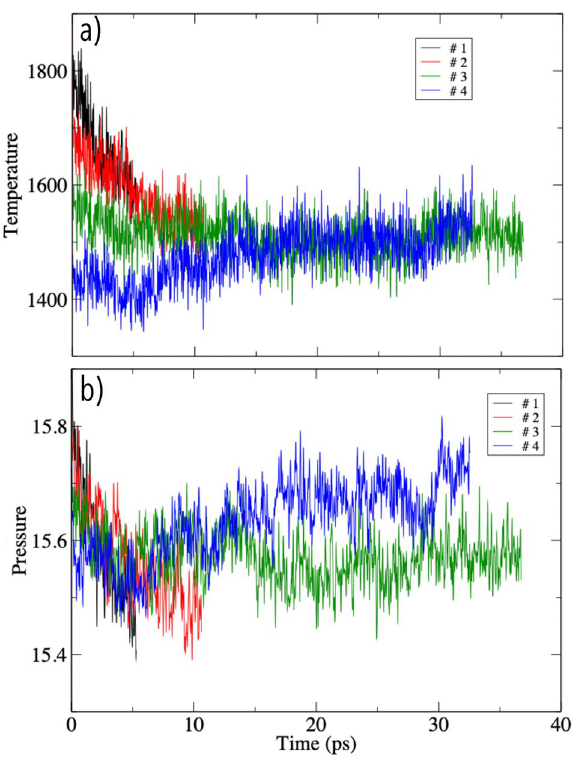
Figure 5. Instantaneous ( a ) temperature and ( b ) pressure of four solid-liquid coexistence simulations with different amount of internal energy. Simulation # 1 and # 2 both melt after ~ 5 and ~ 10 ps, respectively. In simulations # 3 and #4 solid and liquid coexist for the whole duration of the